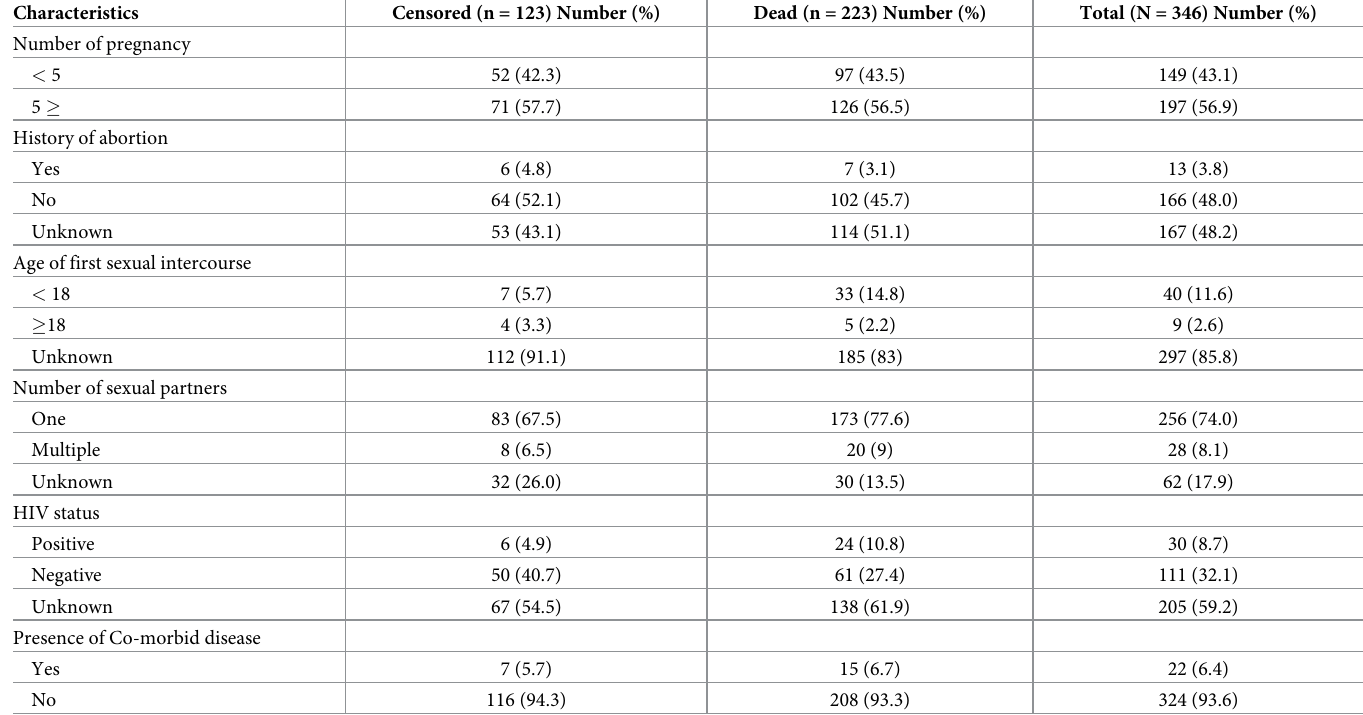
Table 2. Past obstetrics and medical history of CCP in TASH from July 2014 –July 2019.